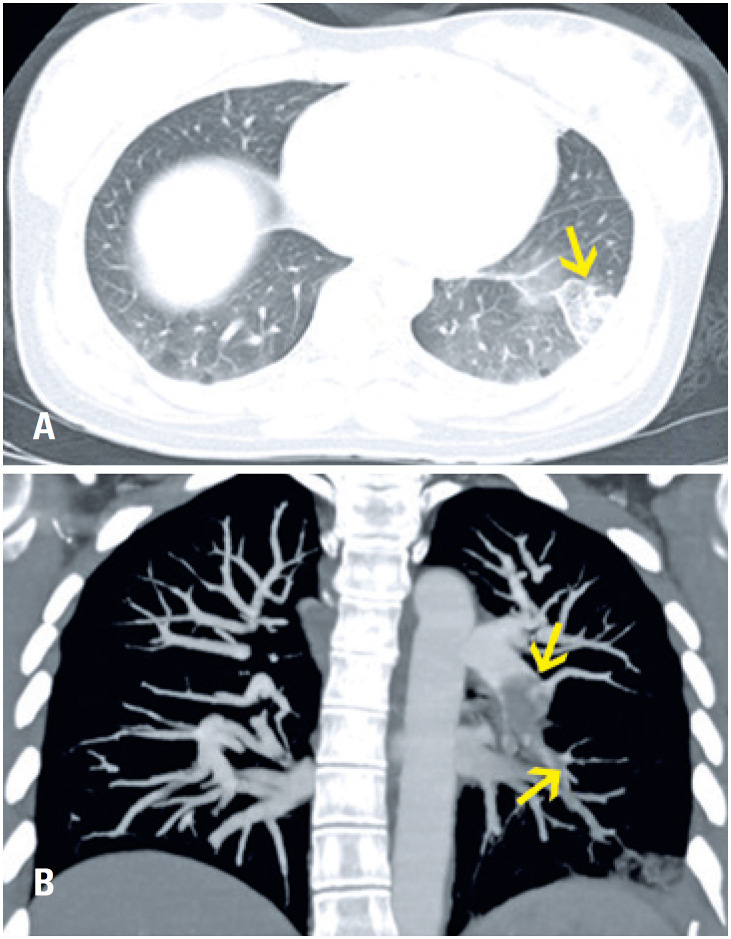
Mulher, 30 anos, com queixa de dispneia súbita. Tomografia computadorizada (A) Com corte axial (B) Reformatação coronal com reconstrução (projeção de intensidade máxima) da janela de partes moles: angiotomografia positiva para tromboembolismo pulmonar, notando-se falhas de enchimento na artéria interlobar esquerda e ramos segmentares para o lobo inferior esquerdo. Pequena opacidade em halo invertido. Em cunha com o ápice voltado para o hilo subpleural no segmento basal lateral do lobo inferior esquerdo, que pode corresponder à área de infarto pulmonar